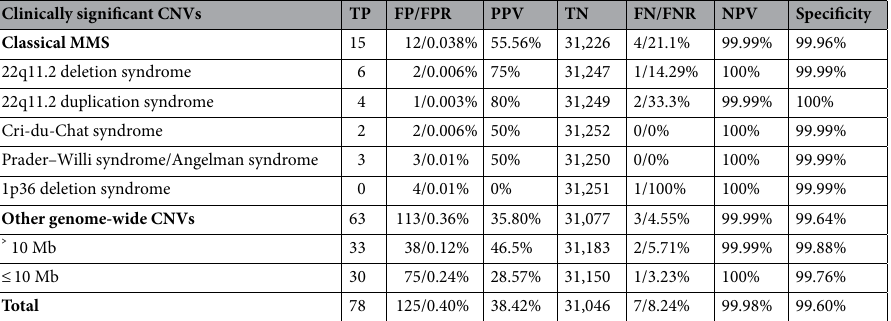
Table 4. Performance of NIPT-Plus for detection of clinically significant CNVs in 31,256 pregnancies. CNV copy number variation, TP true positive, FP false positive, FPR false positive rate, PPV positive predictive value, TN true negative, FN false negative, FNR false negative rate, NPV negative predictive value.